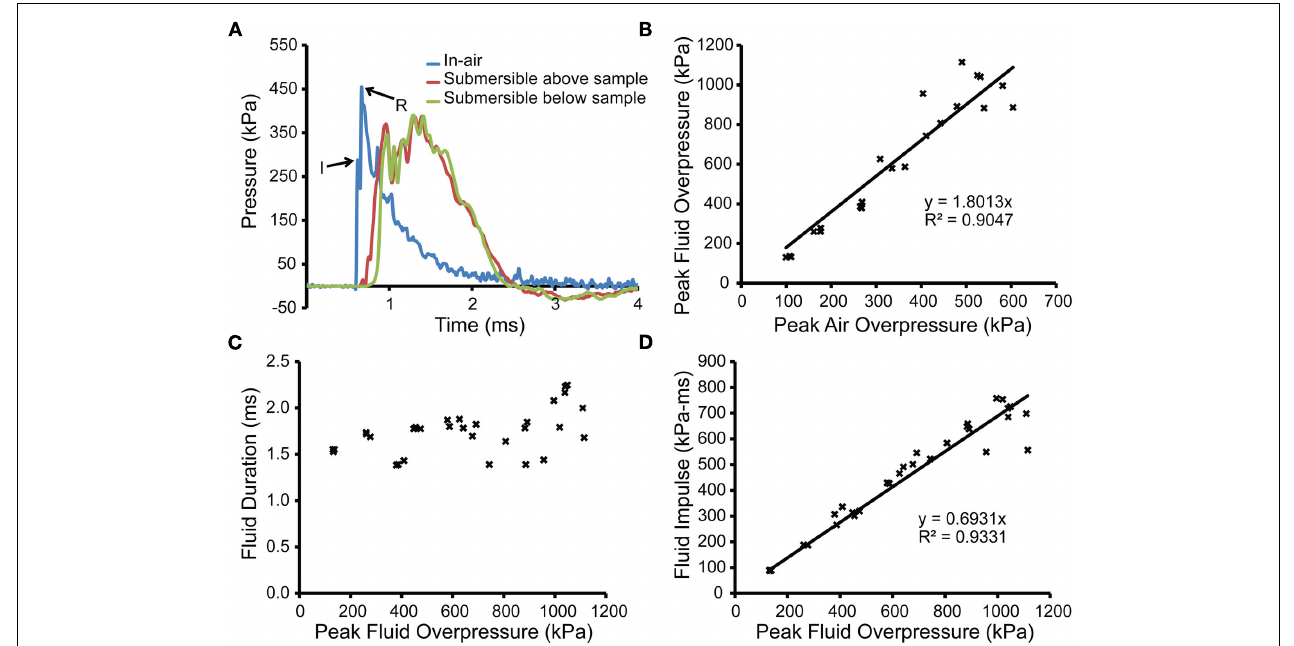
demonstrated the absence of attenuation through the in vitro set-up. (B) The peak overpressures from the submersible transducer below the sample holder were correlated to peak pressures measured by the in-air transducers. (C) The durations within the fluid-filled receiver were plotted against peak overpressures measured within the fluid-filled receiver, with no correlation to pressure found. (D) The impulses within the fluid-filled receiver were correlated to peak overpressures measured within the fluid-filled receiver and approximated using a linear